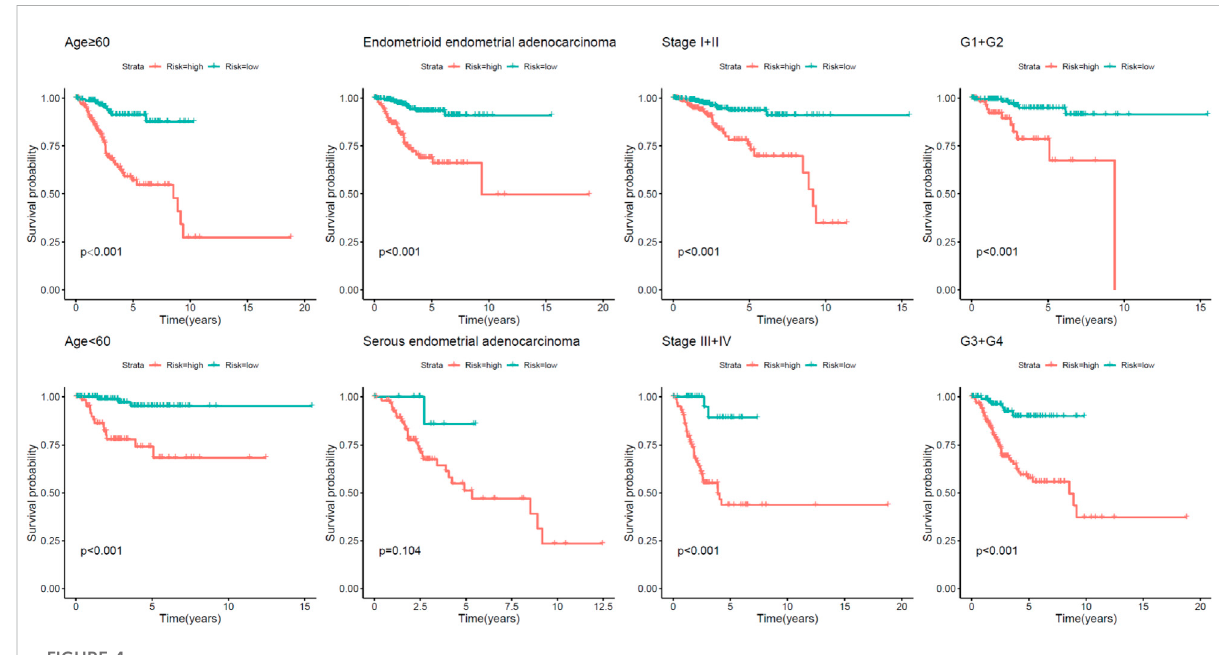
FIGURE 4 Kaplan – Meier analysis of overall survival for UCEC patients according to age, event, histological type, and tumor stage.